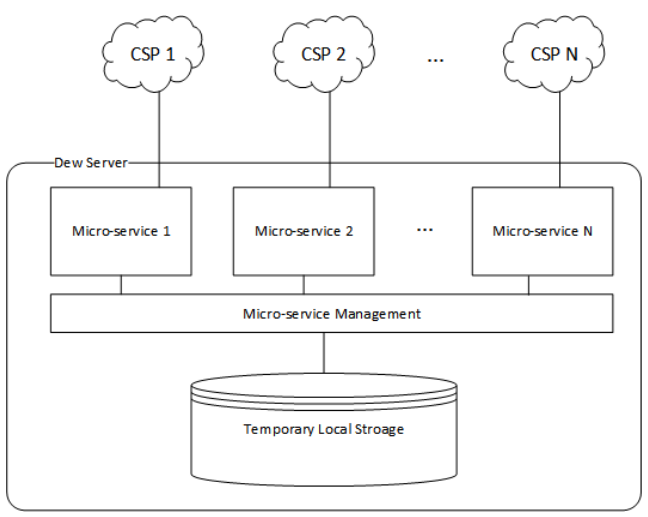
Figure 4. Dew server structure.